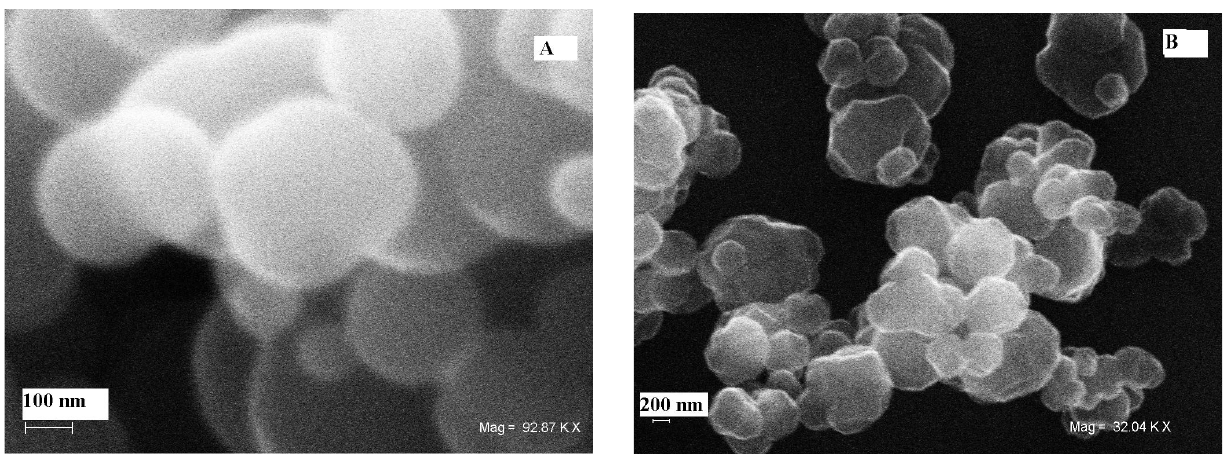
Fig. 1. Typical SEM image of (A) technical carbon (thermal soot) which was chosen for production of EC RM and (B) GTS-6 soot after graphitization of thermal soot.